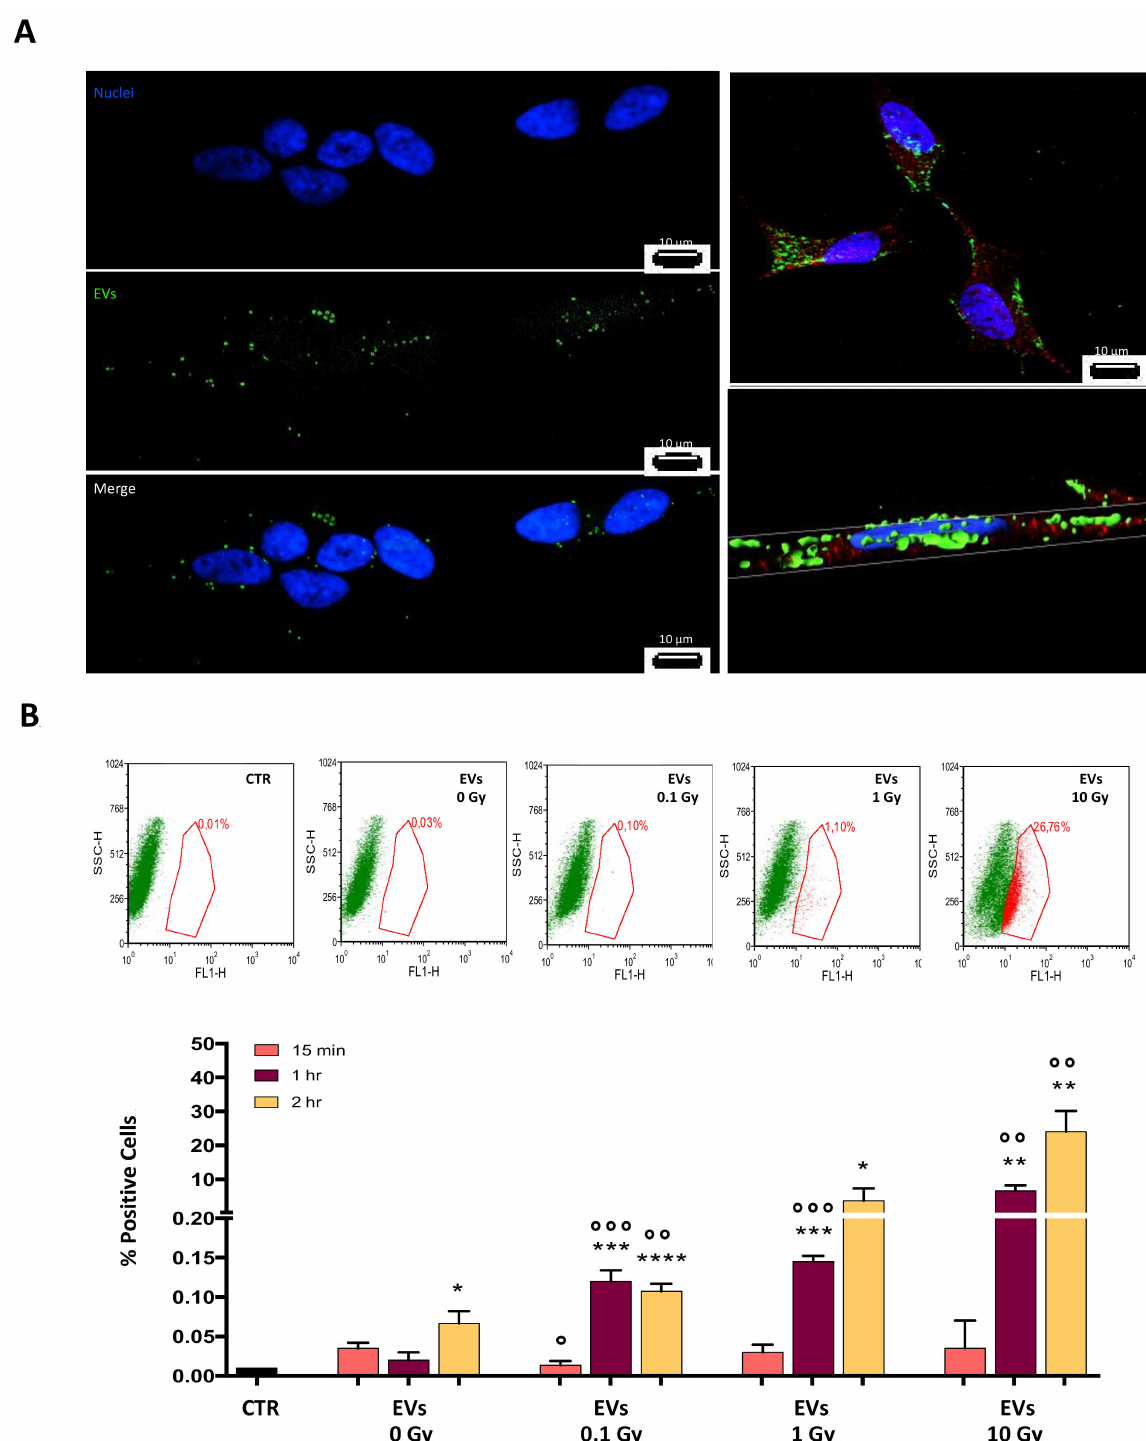
Figure 2. EV uptake by recipient cells. ( A ) SH-SY5Y were incubated with Green SYTO ® RNASelectTM-labelled EVs, and imaged by fluorescence and confocal microscopy (left and right panel respectively); cytoplasm and nuclei were stained with α -Tubulin and blue Hoechst 33342, respectively. The right panel represents the three-dimensional reconstructed images of the confocal microscopy analysis; ( B ) SH-SY5Y were incubated with Green SYTO ® RNASelectTM-labelled EVs and analyzed by flow cytometry. Representative FL1-H vs. SSC-H dot plots showing the gating strategy (red boxes) used to determine cells that had incorporated the labelled EVs (upper panel). Flow cytometry analysis of labelled EVs uptake by SH-SY5Y cells after 15 min, 1 h, and 2 h treatment (bottom panel). Data are expressed as means ± S.D. (n = 4, * p < 0.05, ** p < 0.01, *** p < 0.001, **** p < 0.0001 vs. 15 min uptake; n = 4, ◦ p <0.05, ◦◦ p < 0.01, ◦◦◦ p < 0.001 vs. 0